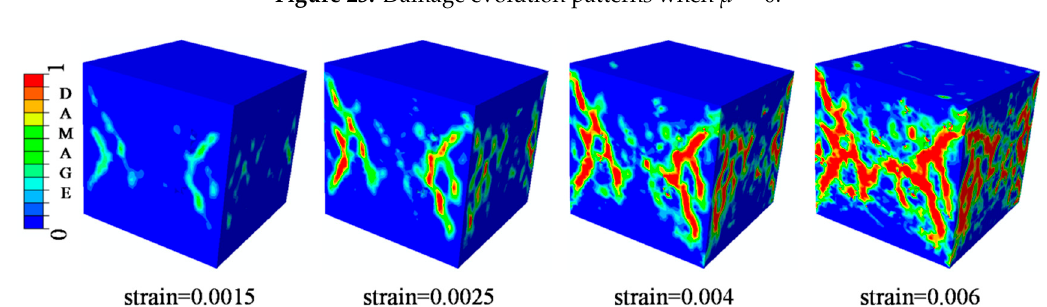
Figure 24. Damage evolution patterns when µ = 0.6